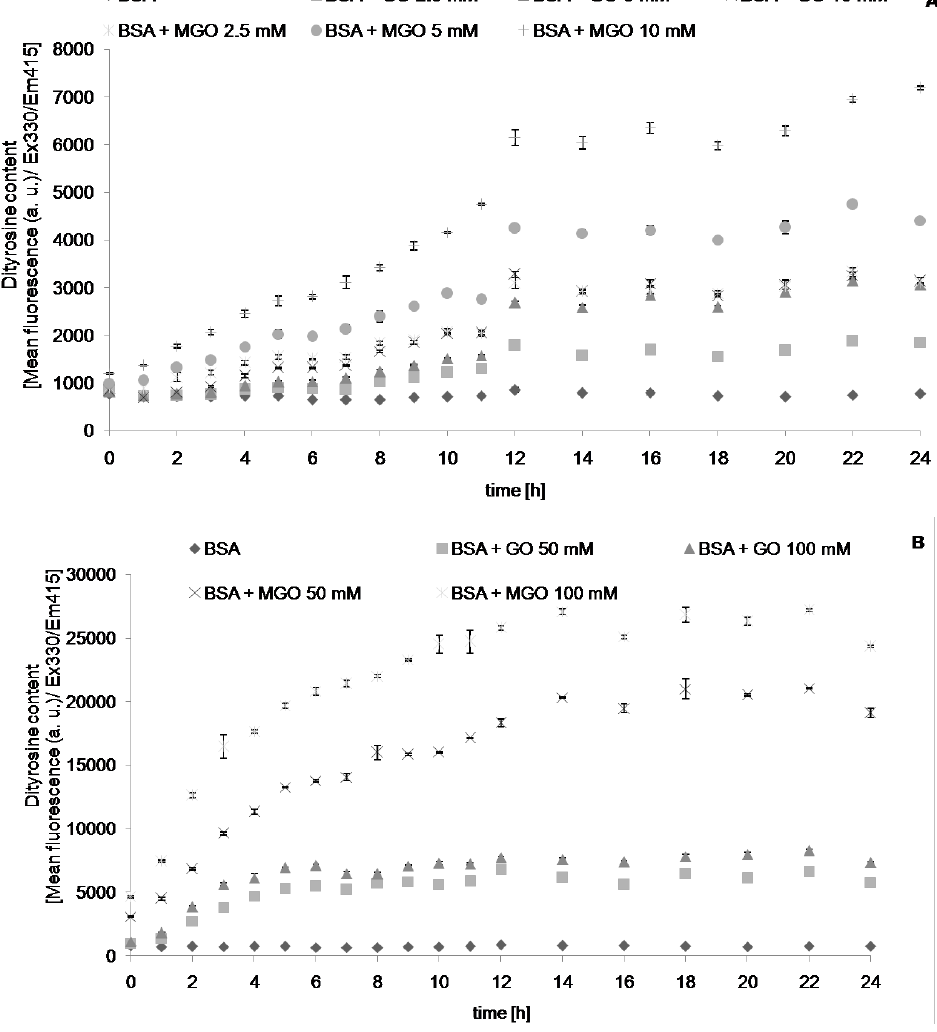
Figure 3. The time course of N ′-formylkynurenine fluorescence during incubation of BSA (0.09 mM) with 2.5, 5 and 10 mM ( A ), and 50 and 100 mM ( B ) GO and MGO at 37